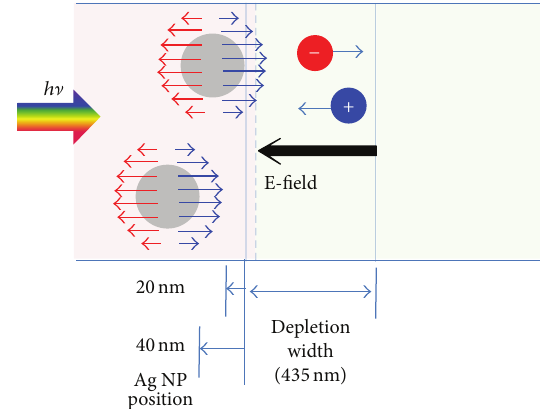
Figure 12: Schematic of localized surface plasmon (LSP) energy transferred from Ag NPs directly into the depletion layer